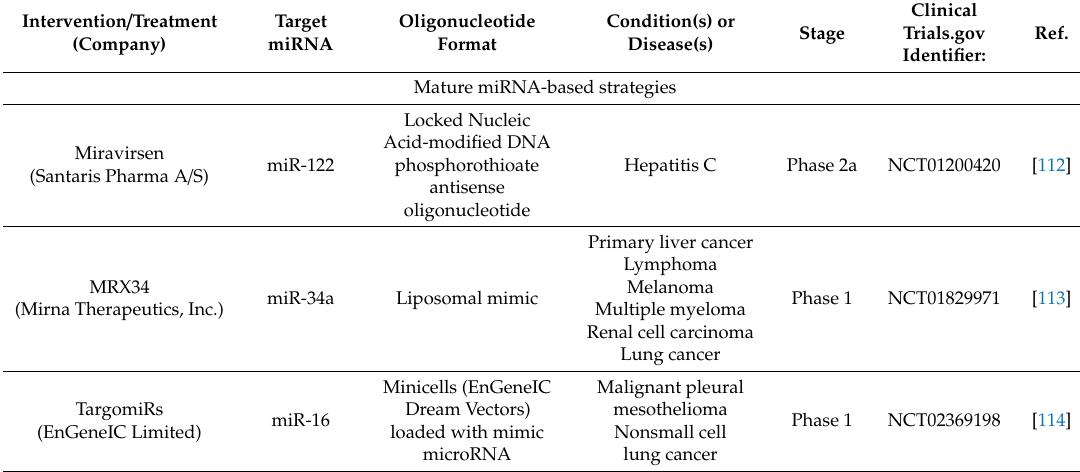
Table 3. Selected examples of developing miRNA